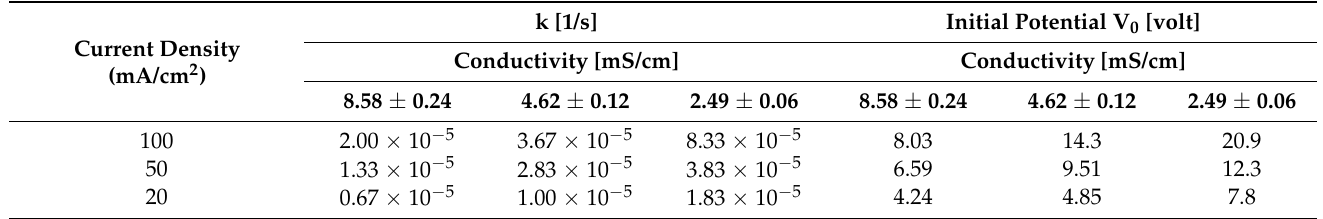
Table 1. Reaction rate constant k and initial potential V 0 at different electrolyte conductivities and current densities.